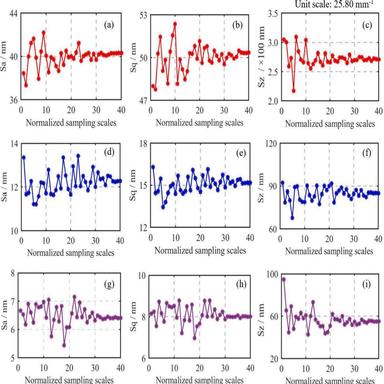
Surface texture parameters under different sampling scales at the machining conditions of I - (a) Sa, (b) Sq, and (c) Sz, II - (d) Sa, (e) Sq, and (f) Sz, and III - (g) Sa, (h) Sq, and (i) Sz.